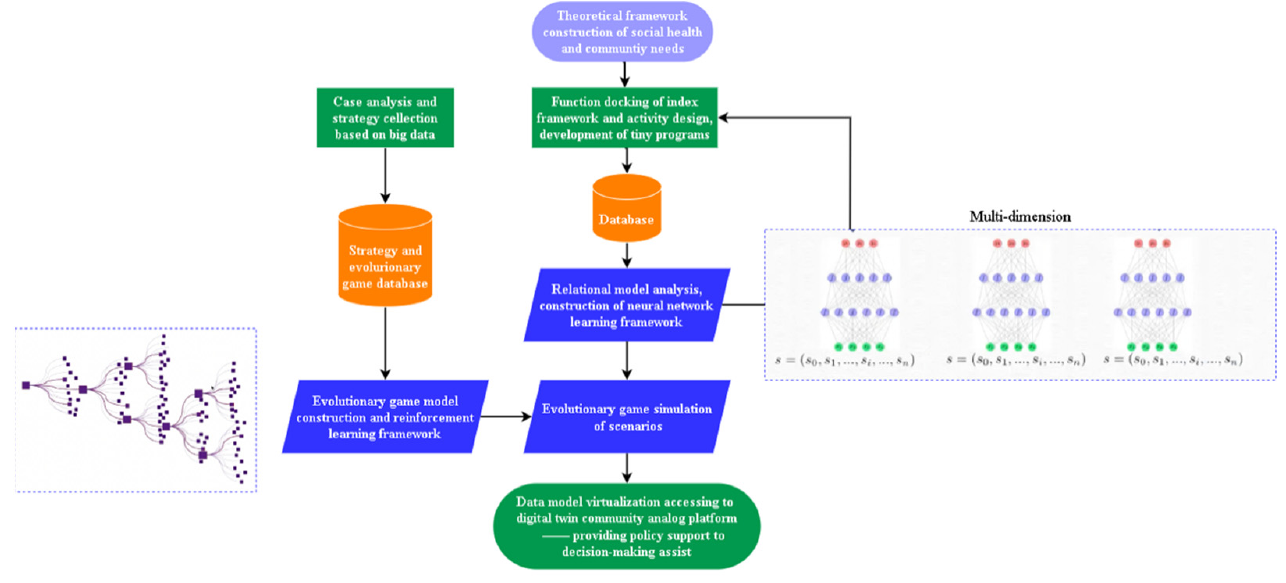
Figure 2. The conceptual framework of using machine learning neural networks algorithms and reinforcement learning.